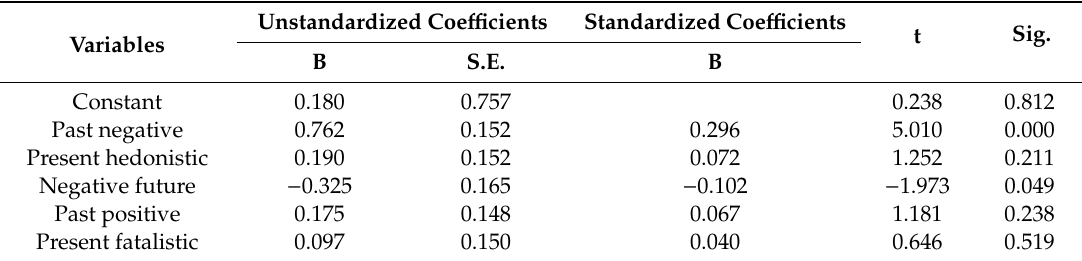
Table 3. Personality Predictors of emotional exhaustion.